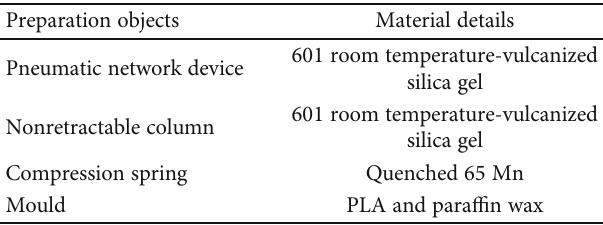
Figure 7: Error analysis of theoretical deformation analysis model. Table 3: Material